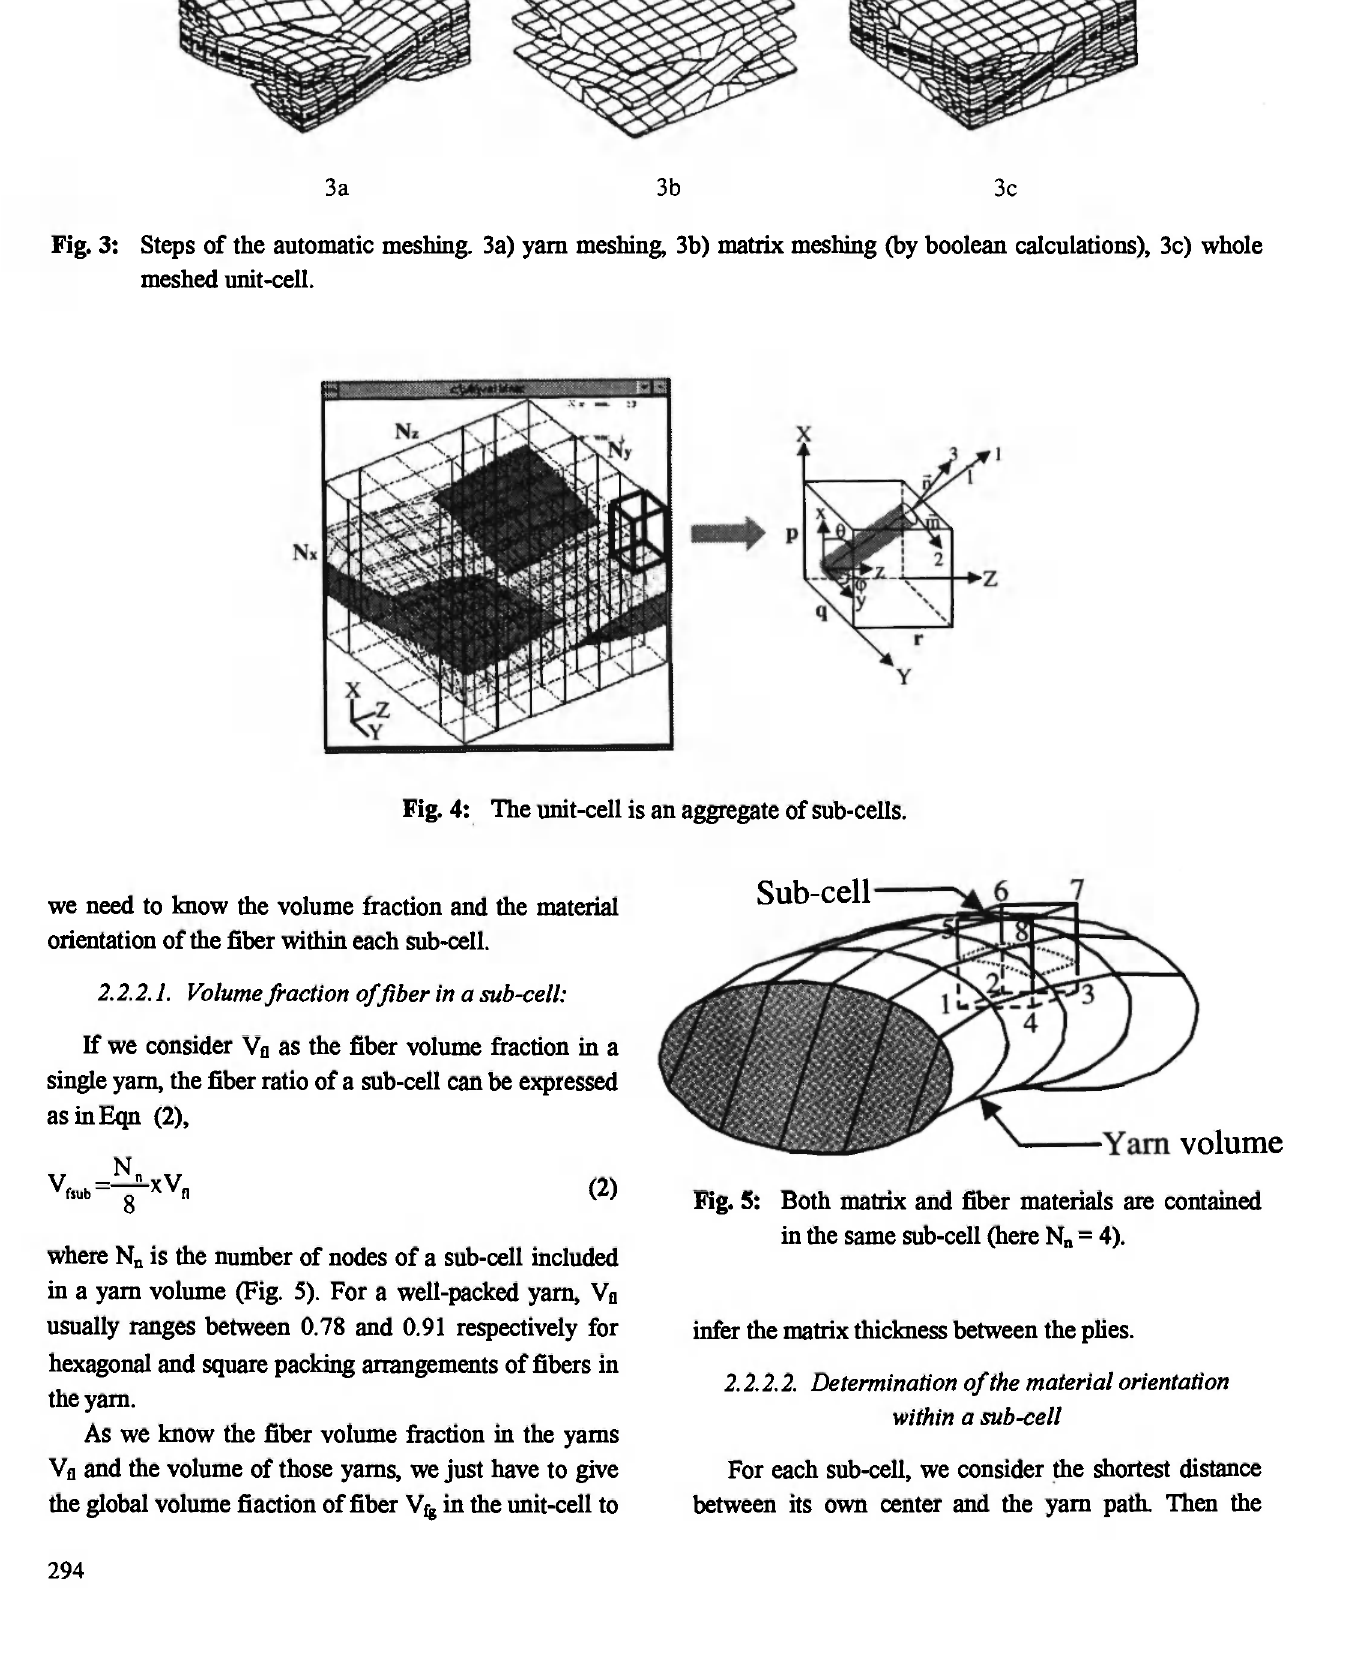
Fig. S: Both matrix and fiber materials are contained in the same sub-cell (here N